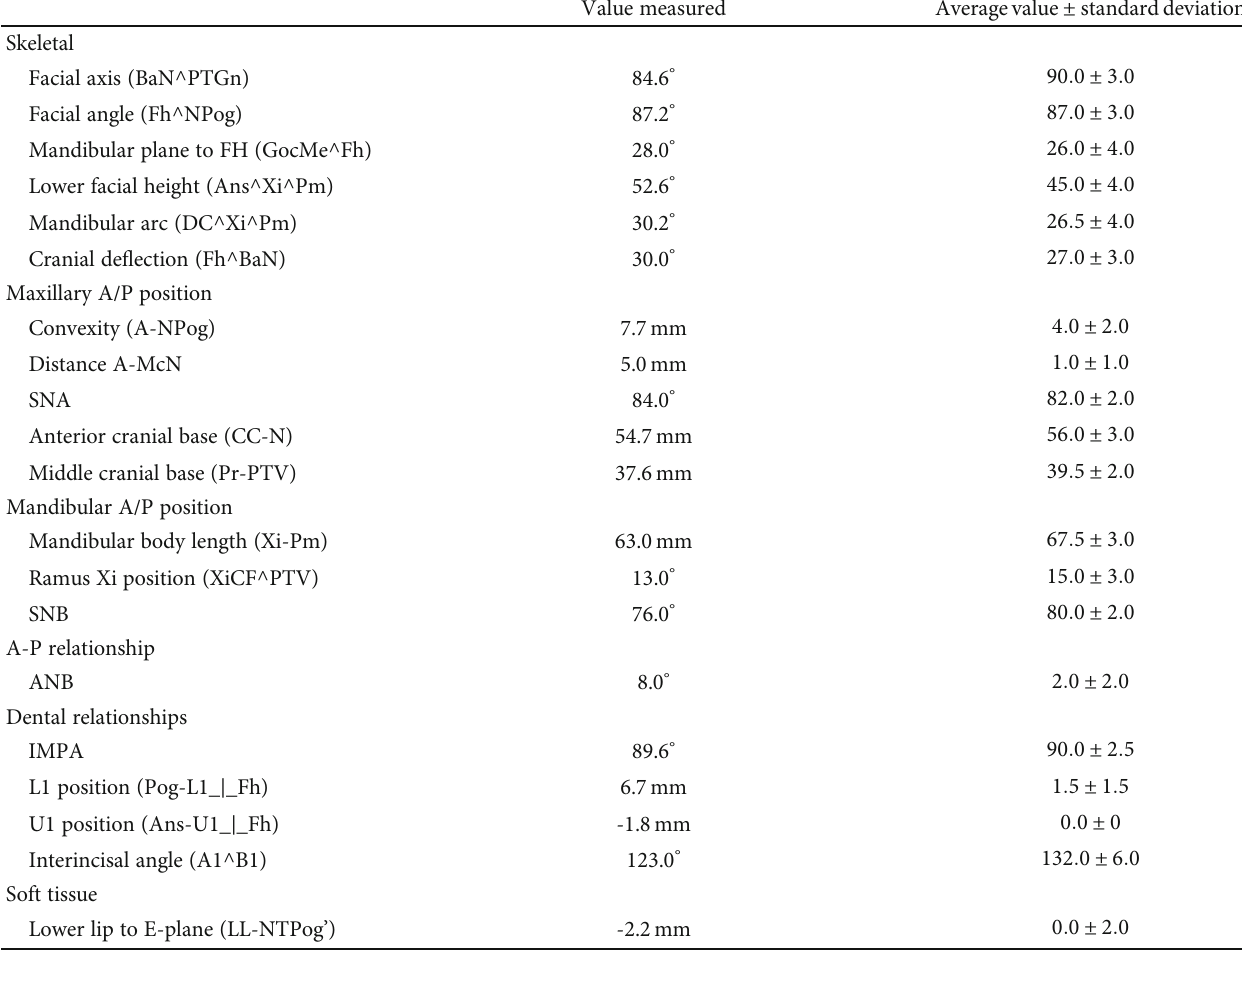
Table 1: Cephalometric values at the start of the treatment.